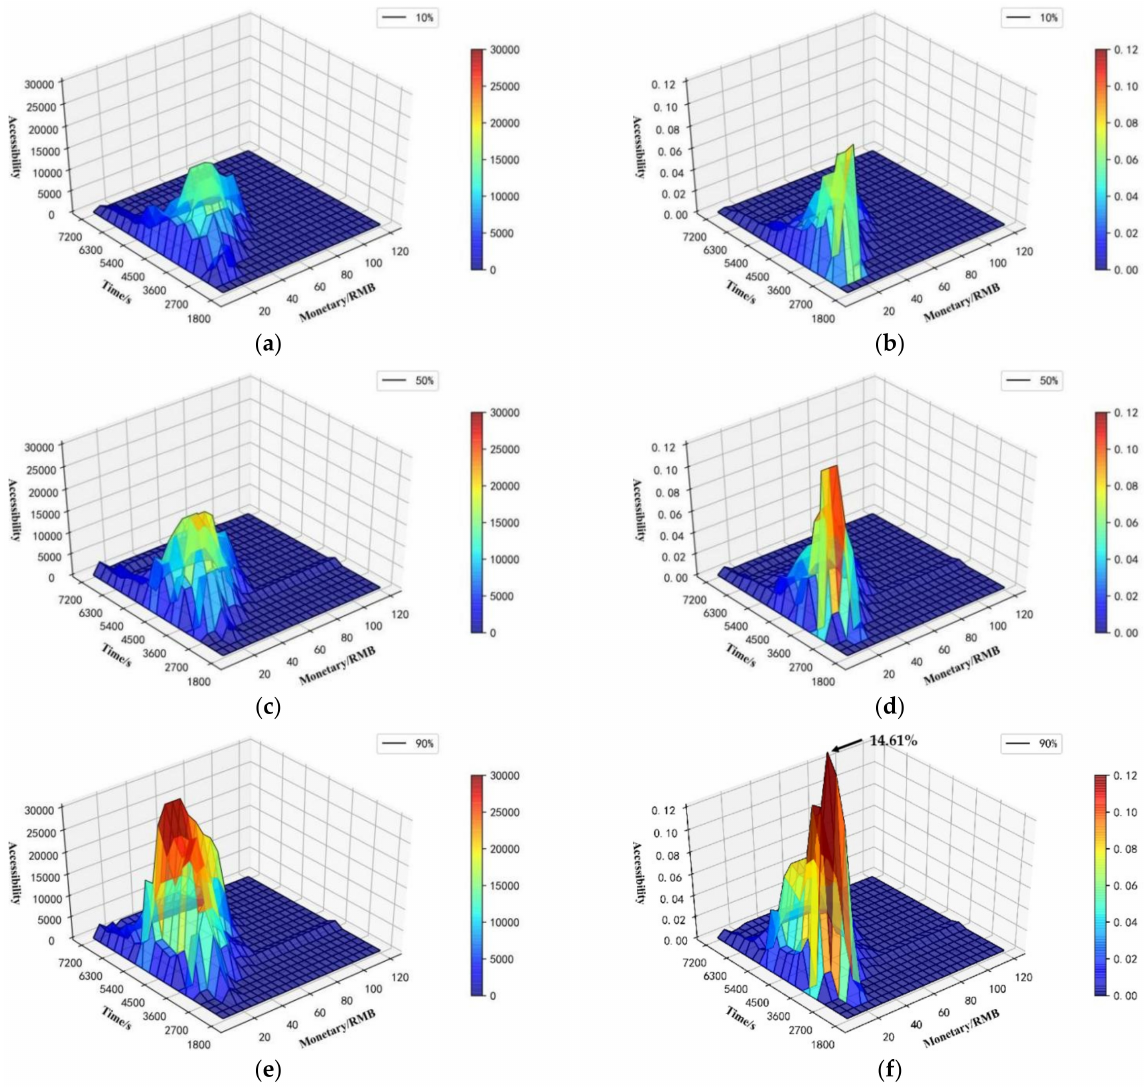
Figure 11. The difference and ratio between unimodal accessibility and multimodal accessibility: ( a , b ) the difference and ratio at 10% reliability, ( c , d ) the difference and ratio at 50% reliability, and ( e , f ) the difference and ratio at 90%